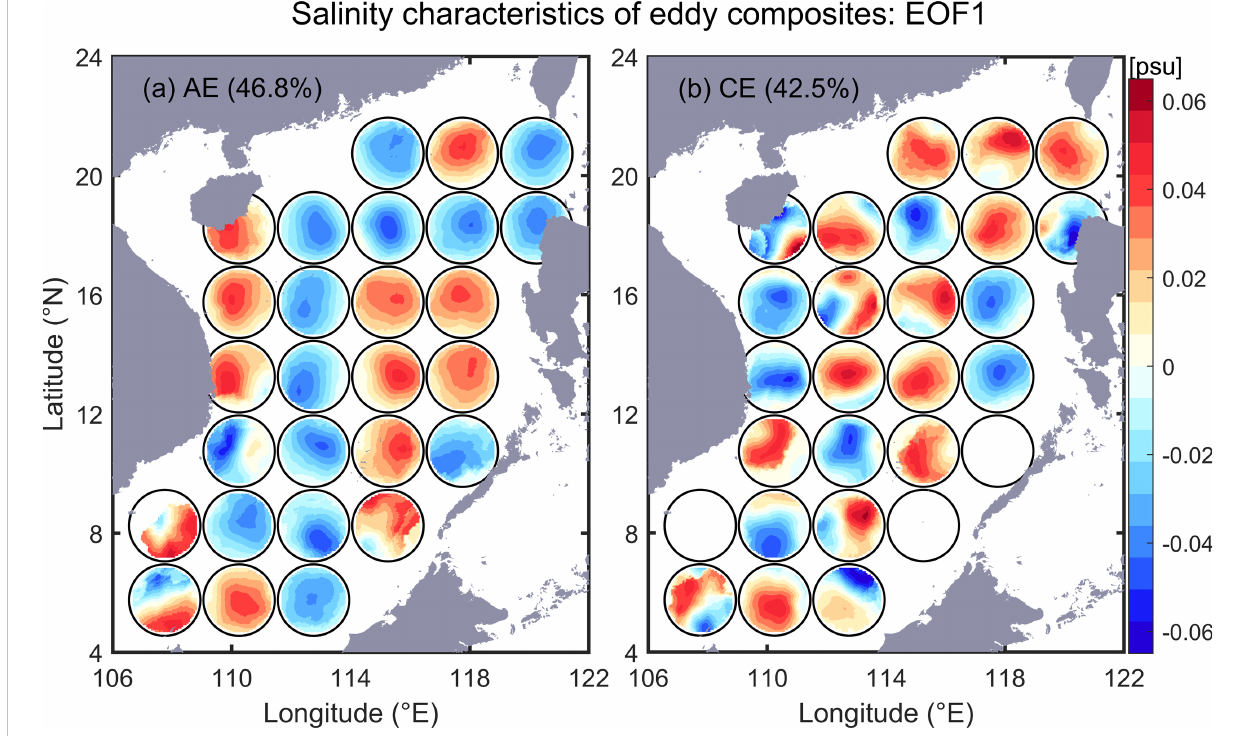
FIGURE 6 The fi rst spatial pattern of the EOF of the (A) AE and (B) CE in the SCS. The shading indicates the salinity anomaly mode of the eddy